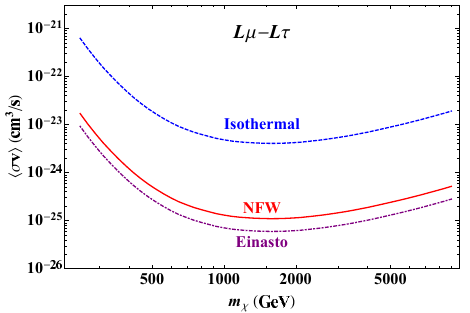
Figure 5 . HESS upper limits on h (cid:27)v i ( (cid:31) (cid:22) (cid:31) ! V 2 V 2 ) where V 2 is a gauged L (cid:22) (cid:0) L (cid:28) boson. We considered three di(cid:11)erent DM pro(cid:12)les: NFW (solid), isothermal (dashed), and Einasto (dot-dashed). Here only gamma rays from the MW halo are considered. The limits are computed based on the exclusion limits for the (cid:31) (cid:22) (cid:31) ! (cid:22) + (cid:22) (cid:0) and (cid:31) (cid:22) (cid:31) ! (cid:28) + (cid:28) (cid:0) processes given in ref. [59]. A light V 2 mass is assumed in this